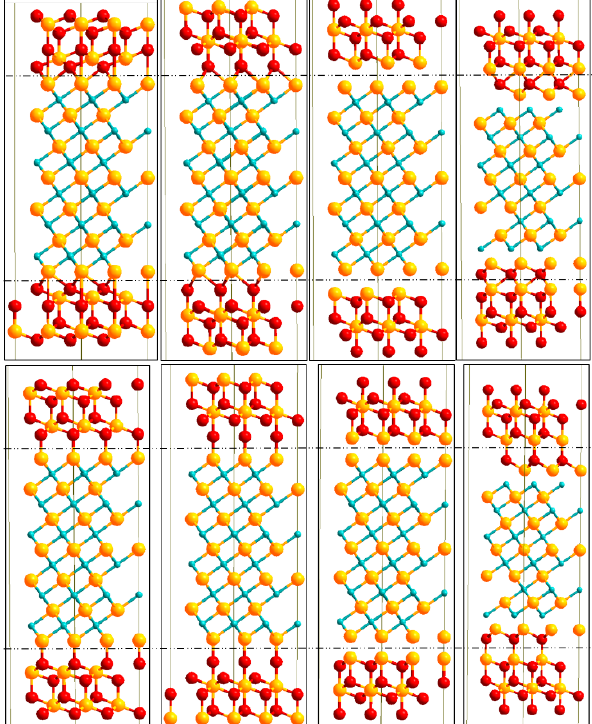
Figure 2. Side views of different interface model slabs using two layers of c -ZrO 2 (111). Top structures are models with fcc bonding sites at the interface with corresponding on-top interface bonding sites in the bottom structures. Yellow (Zr), light blue (C), and red (O).